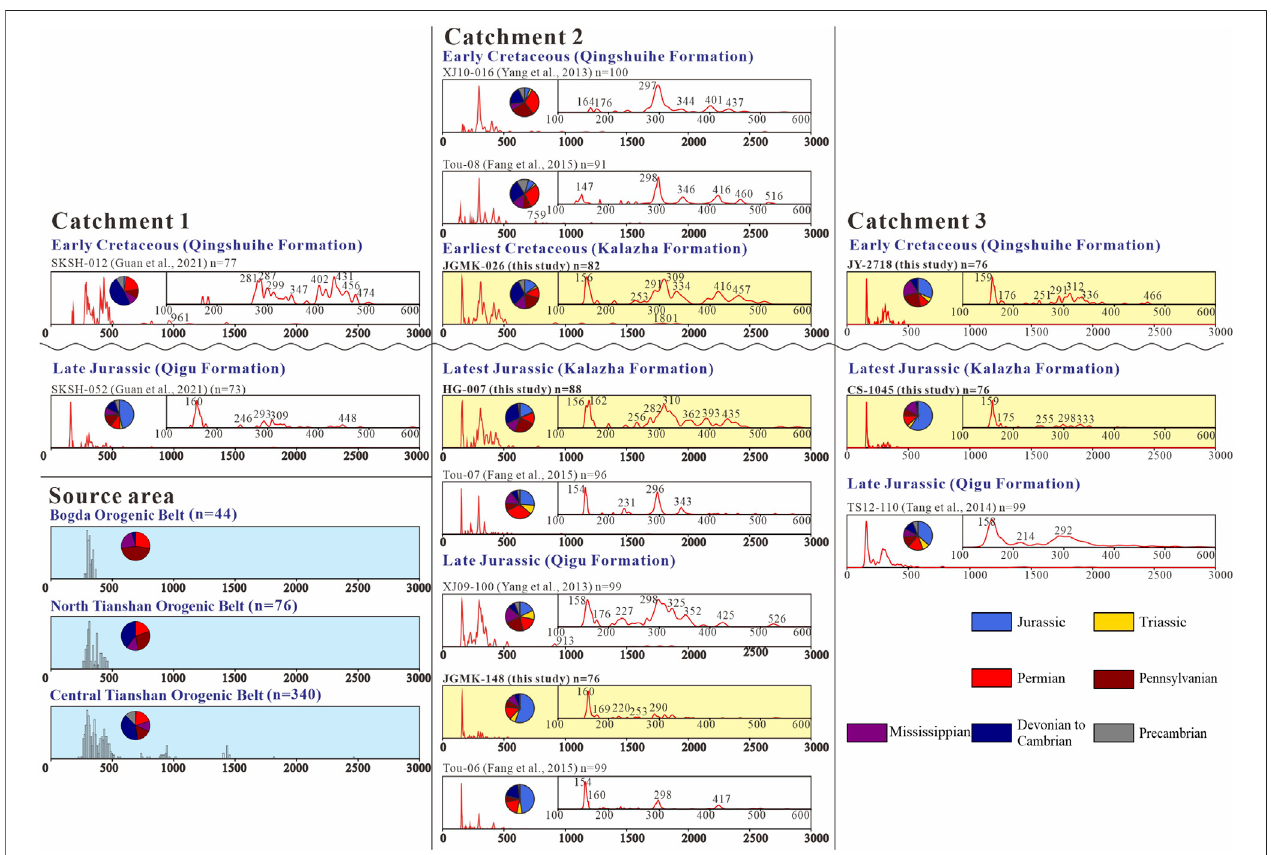
FIGURE 10 | Histogram of the crystallization ages from the Bogda, North Tianshan, and Central Tianshan Orogenic Belts (blue backgrounds) and the probability densityplotsofintheSouthernJunggarBasin(catchments1and2),includingthe8collecteddata(Yang,etal.,2013;Tang,etal.,2014;Fangetal.,2015).Thesamples withyellowbackgroundsarefromthisstudy.Theinsetsubgraphsdisplaytheprobabilitydensityplotsoftheagedistributionsofzirconsrangingfrom600to100 Ma.The sample positions see Detrital zircon geochronology and Figure 1C . The samples above the wavy line are Cretaceous and the samples below the wavy line are Jurassic. Data for samples and source areas can be found in Supplementary Files S2 and S3, respectively.